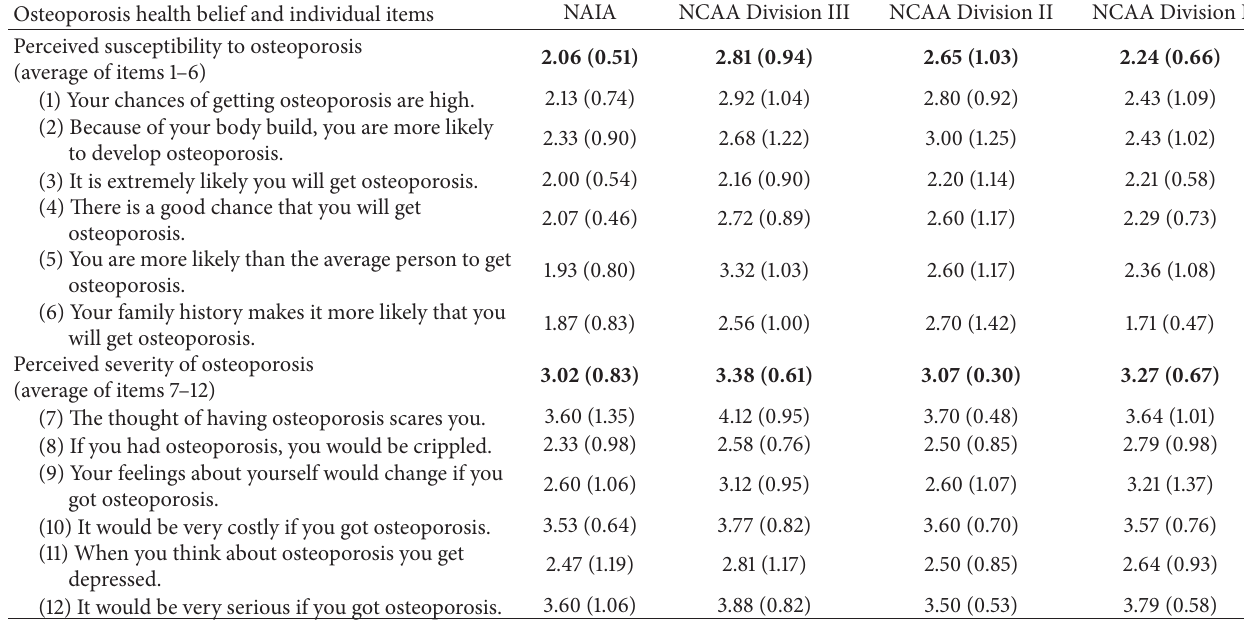
Table 2: Osteoporosis health belief average and individual item scores for levels of competition. Osteoporosis health belief and individual items